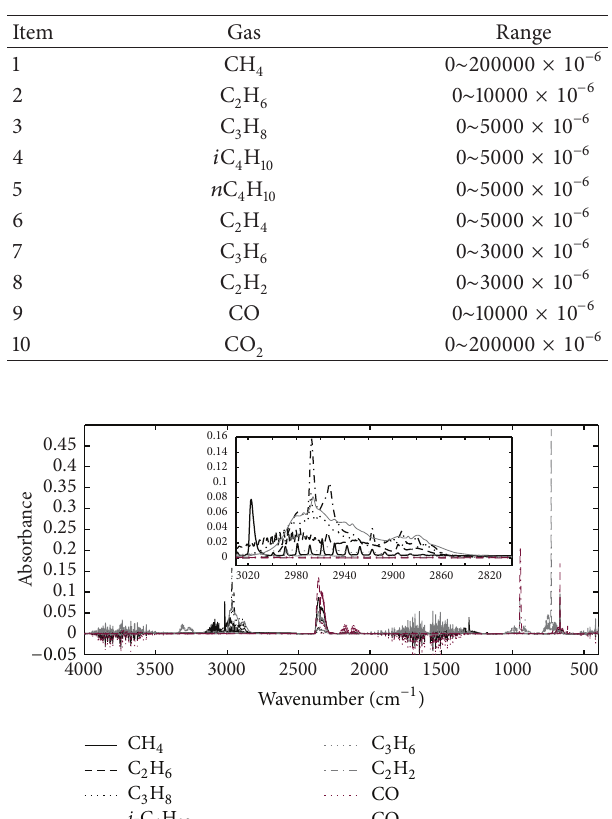
Table 1: Concentration range of every component of index gas.